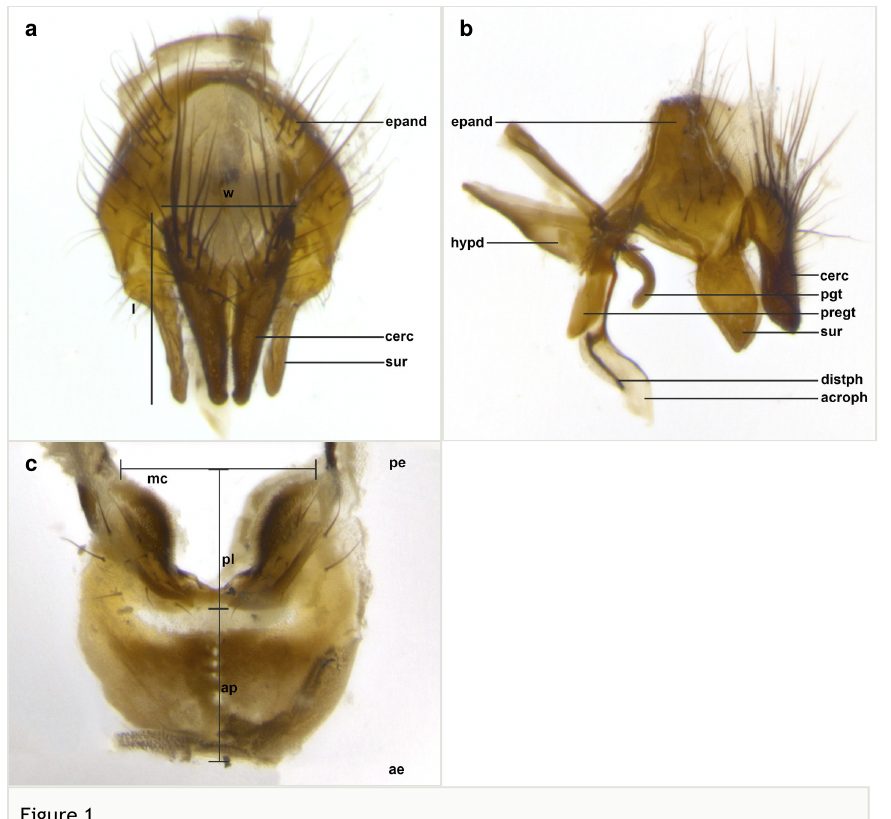
Features and landmarks of the terminalia of Vibrissina spp.; Abbreviations: acroph = acrophallus; ae = anterior edge; ap = anterior plate; cerc = cercus; distph = distiphallus; epand = epandrium; hypd = hypandrium; l = length; mc = median cleft; pe = posterior edge; pl = posterior lobes; pregt = pregonite; pgt = postgonite; sur = surstylus; w = width. a : lateral view of terminalia of V. danmartini sp. n. b : dorsal view of terminalia of V. danmartini sp. n. c : ventral view of sternite 5 of V. robertwellsii sp.